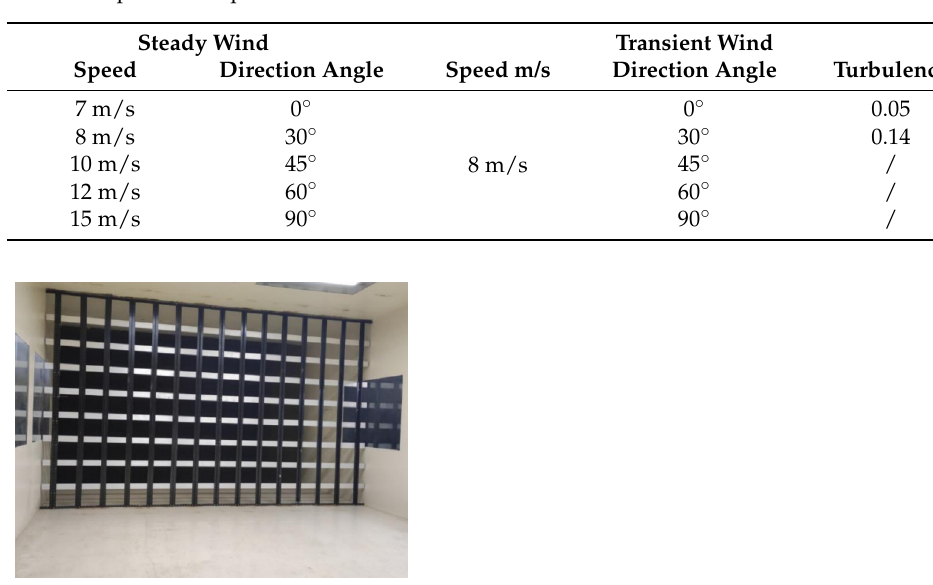
Table 3. Experimental parameters.